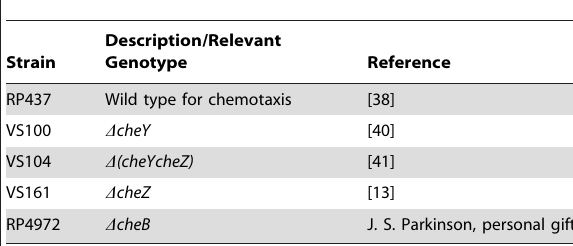
Table 2. Strains used in this study.